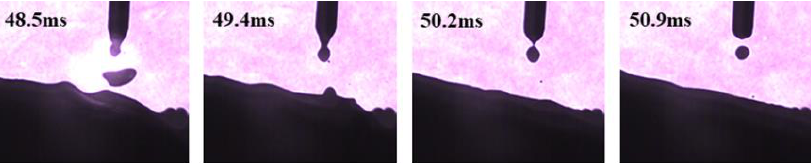
Figure 10. The phenomenon of multi-drop during one pulse ( I p = 525 A).